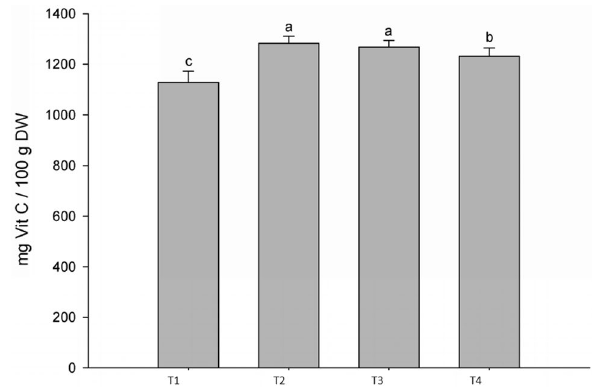
Figure 4. Content of vitamin C in fruits collected in the first “red” harvest (= harvest